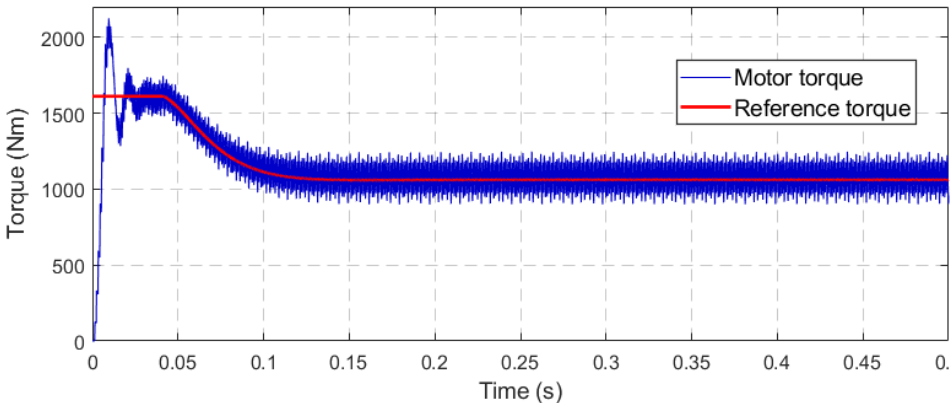
Figure 8. Reference torque and measured torque, (0, 0.5 s).